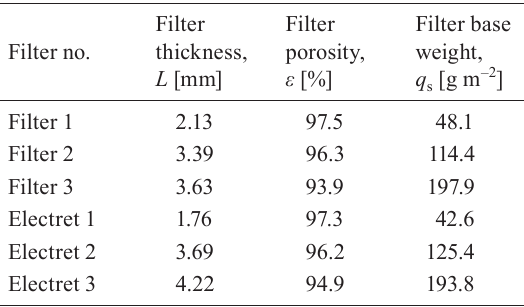
Table 1 Structural characteristics of the tested fibrous filters Filter